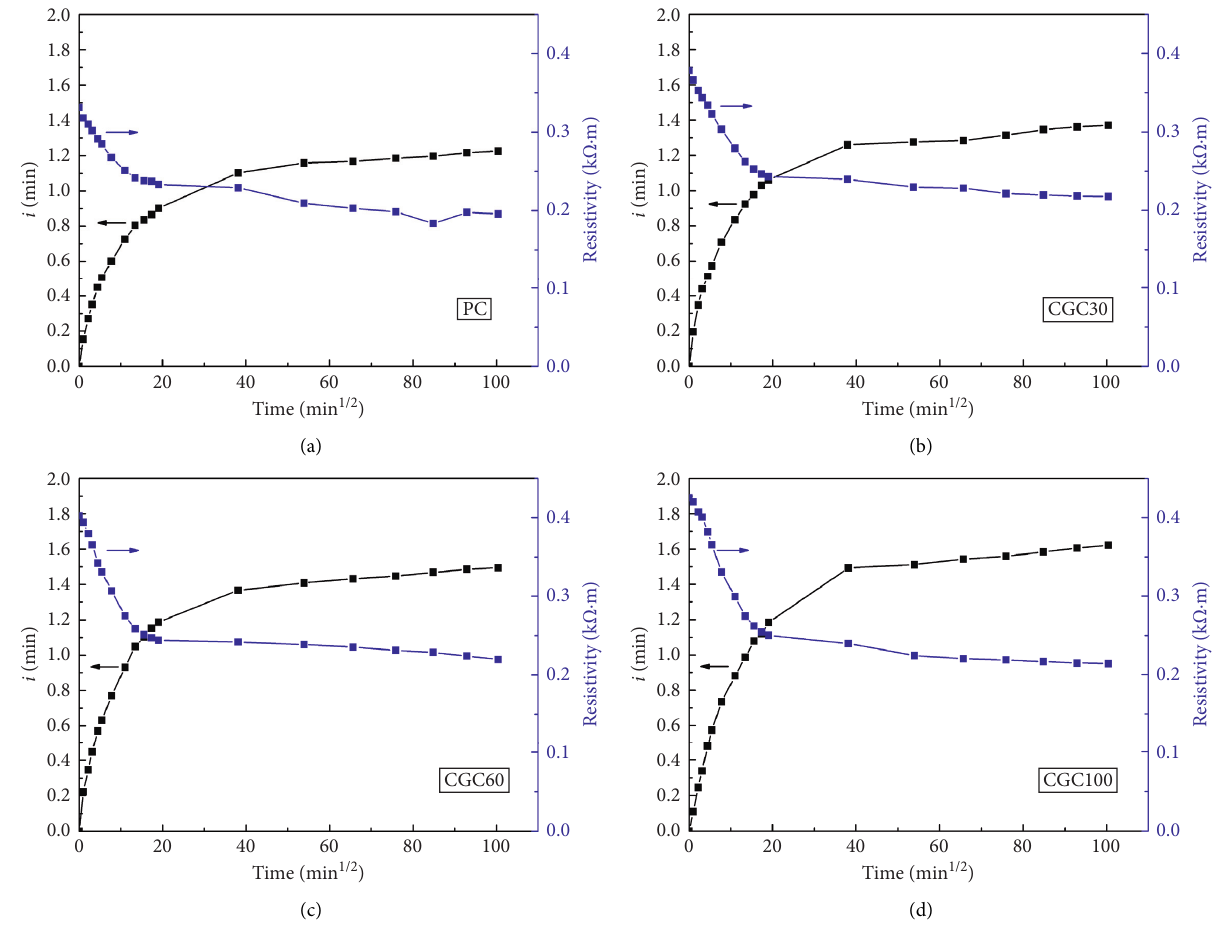
Figure 11: Cumulative water absorption height-resistivity-time curves: (a) PC; (b) CGC30; (c) CGC60; (d)